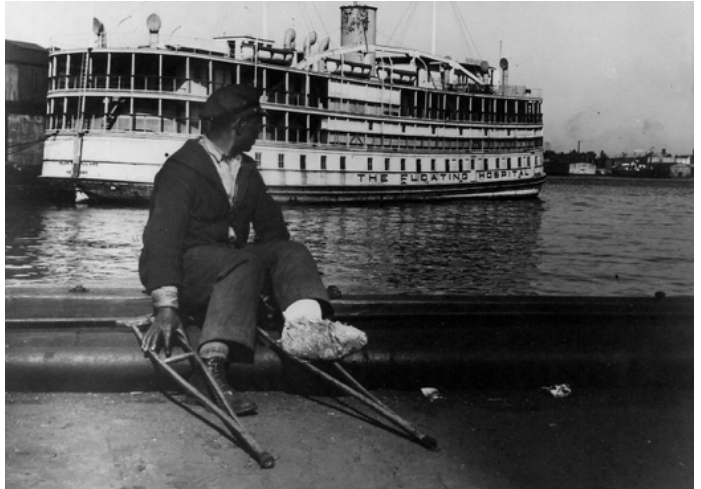
Figure 2. Leo Seltzer, ‘Floating Hospital, East River Dock, New York City’, 1932, gelatin silver print. © Leo Seltzer.